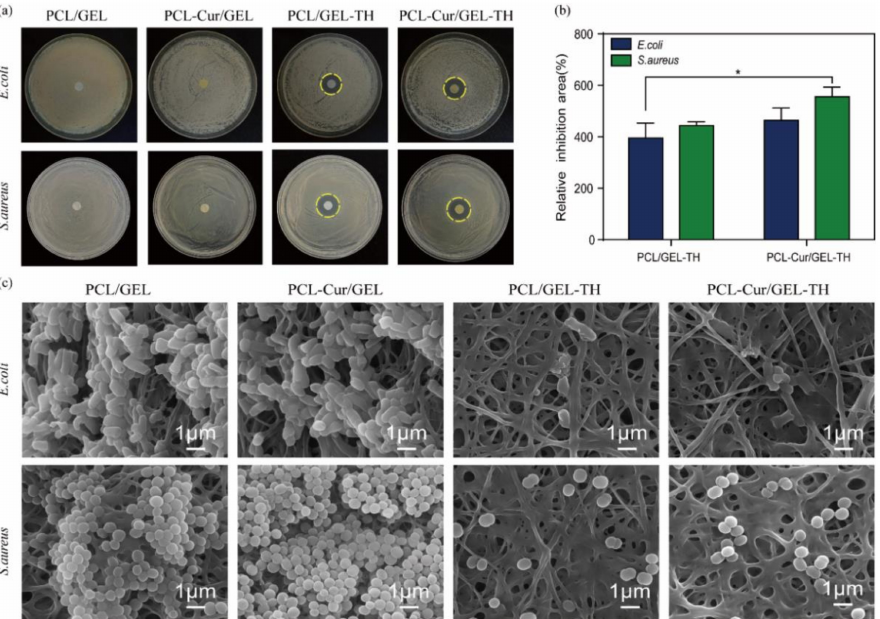
Figure 4. Antibacterial activity of different samples against E. coli and S. aureus . ( a ) Inhibition zone analysis. The yellow dotted circle in the figure is the inhibition zone. ( b ) Inhibition area of different samples ( n = 3). ( c ) SEM images of E. coli and S. aureus on different membranes. * p <